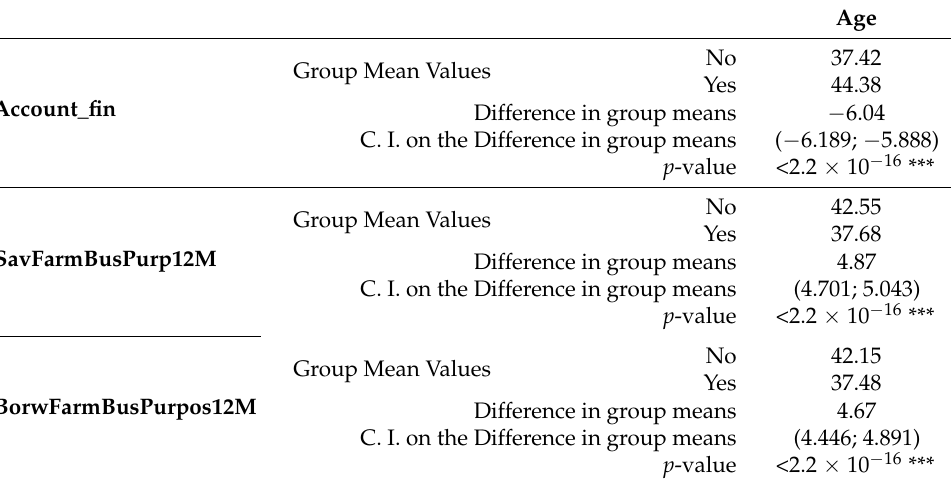
Table A5. Welch two-sample t -test of difference in groups’ means, with corresponding 95% con- fidence interval (C.I.) for the model with formal account ownership, Entrepreneurial saving and Entrepreneurial borrowing